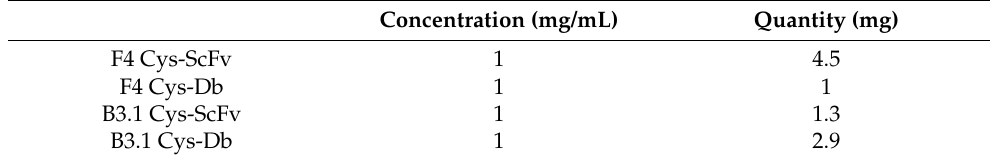
Table 5. Recombinant small antibodies obtained.